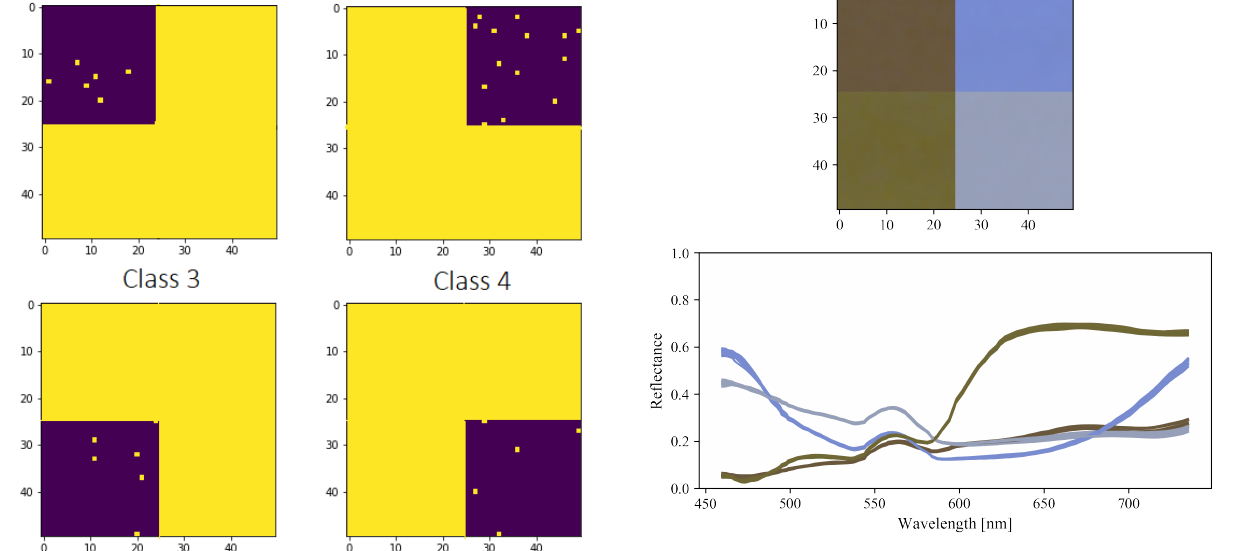
Figure 2: Illustration of the training dataset. Above is an ”RGB” presentation of the ColorChecker dataset in the spatial dimension. Below are the samples of the reflectance spectra from each of the classes. Image is originally from (P¨ol¨onen et al., 2020).